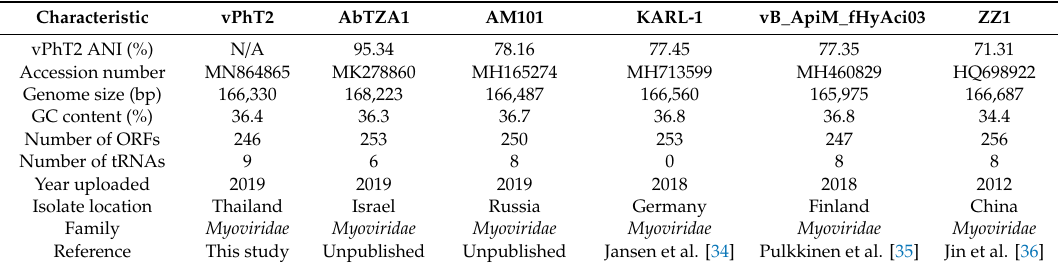
Table 4. Comparison between vPhT2 and its most similar genomes in the NCBI database including pairwise genome comparison ANI-tree similarity matrix compare and gene structure of vPhT2.